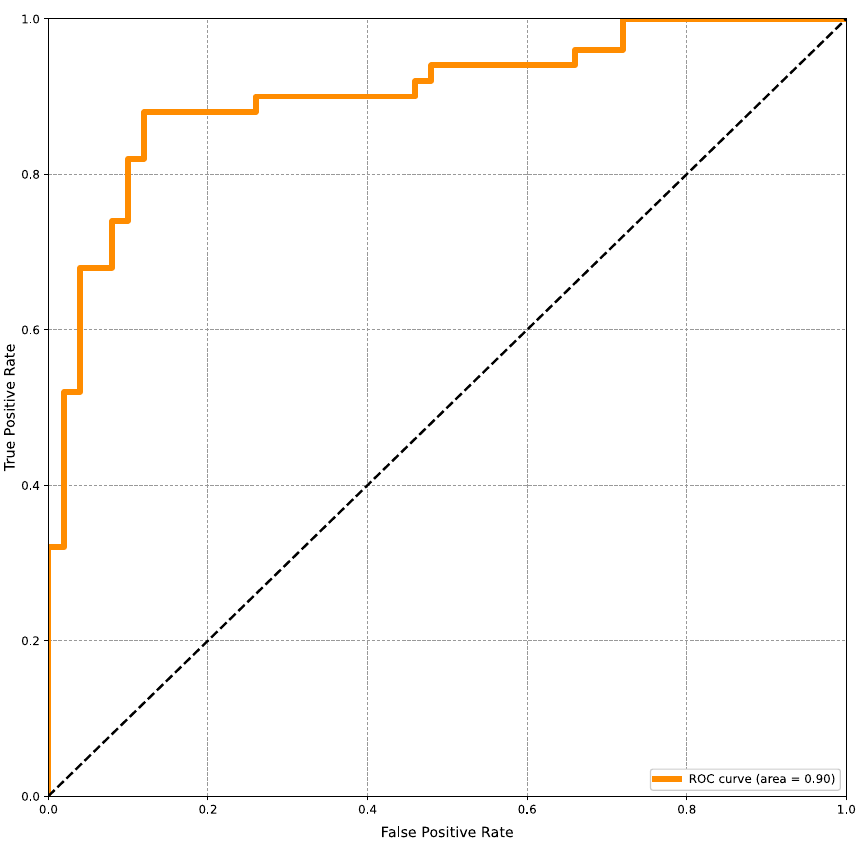
Figure 1. Area-under-the-curve-receiver-operating-characteristics-curve. The ROC curve is created by plotting the true positive rate against the false positive rate at different